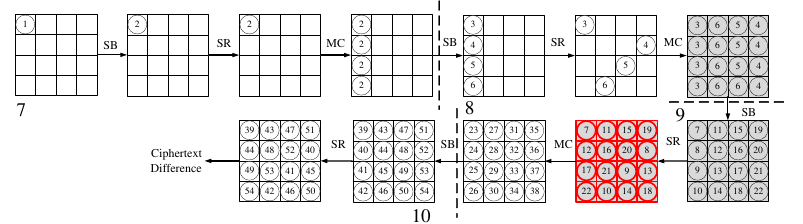
Figure 13: Motivating Example: Fault propagation in impossible differential fault attack on AES in terms of colors from XFC framework. The colors are represented by circled